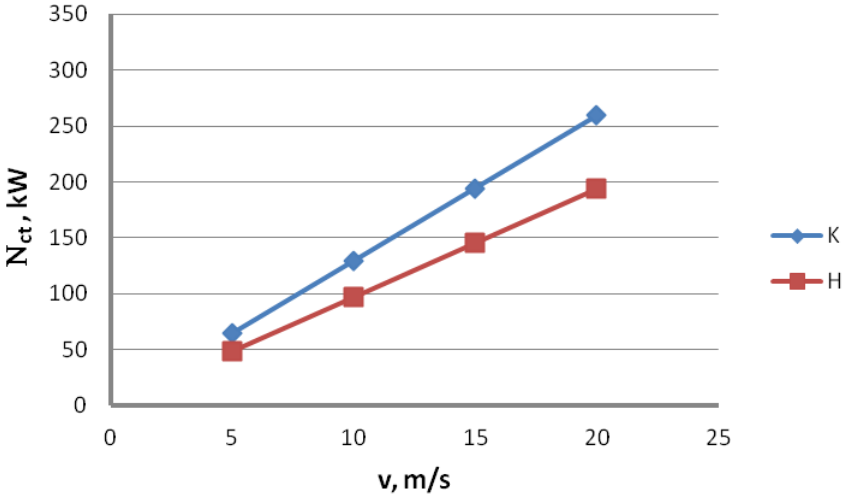
Figure 4. Influence of the drawing speed v on the total drawing power in conventional dies (K) and hydrodynamic dies (H).